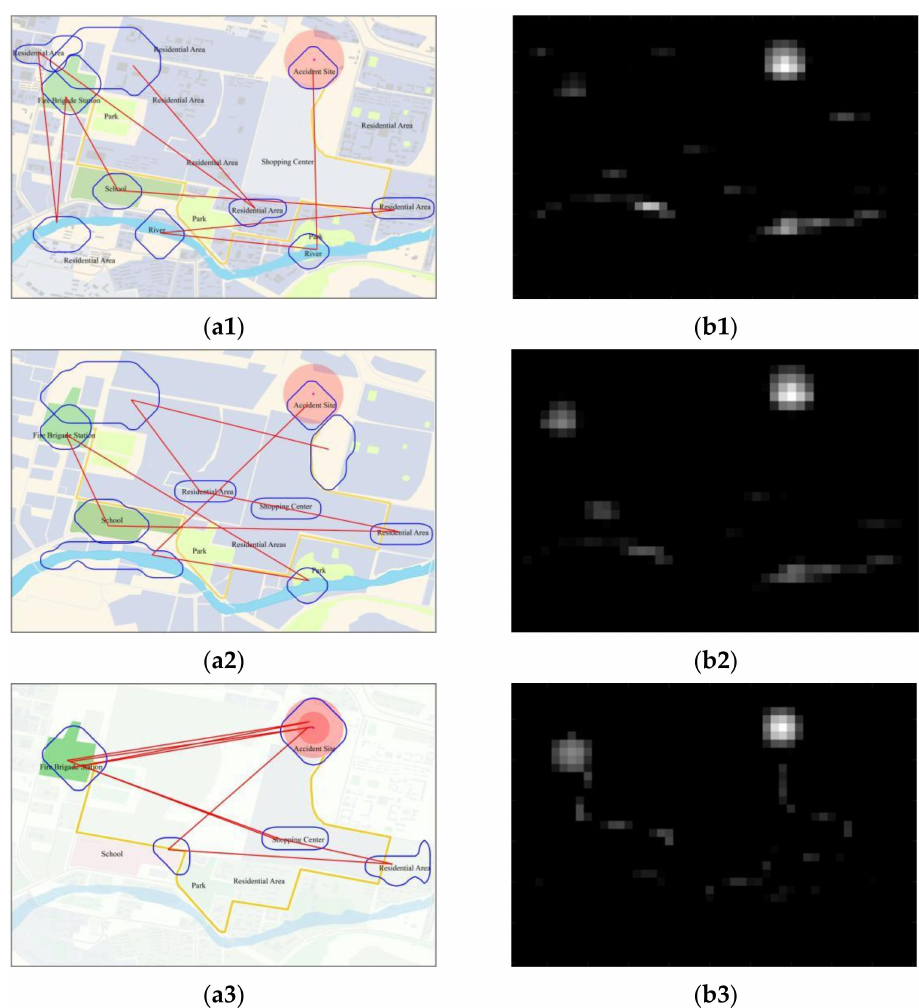
Figure 5. The scan paths and salient regions computed with the Itti model: ( a1 ) the scan paths of the non-relevance filtered and non-saliency map; ( b1 ) the salient regions of the non-relevance filtered and non-saliency map; ( a2 ) the scan paths of the relevance filtered but non-saliency map; ( b2 ) the salient regions of the relevance filtered but non-saliency map; ( a3 ) the scan paths of the relevance filtered and saliency map; and ( b3 ) the salient regions of the relevance filtered and saliency